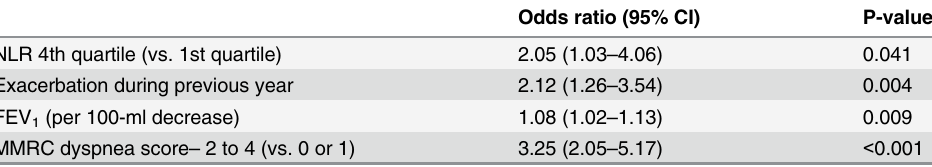
Table 4. Factors Associated with an Exacerbation During the First Year in the Multivariate Model * . Odds ratio (95% CI) P-value NLR 4th quartile (vs. 1st